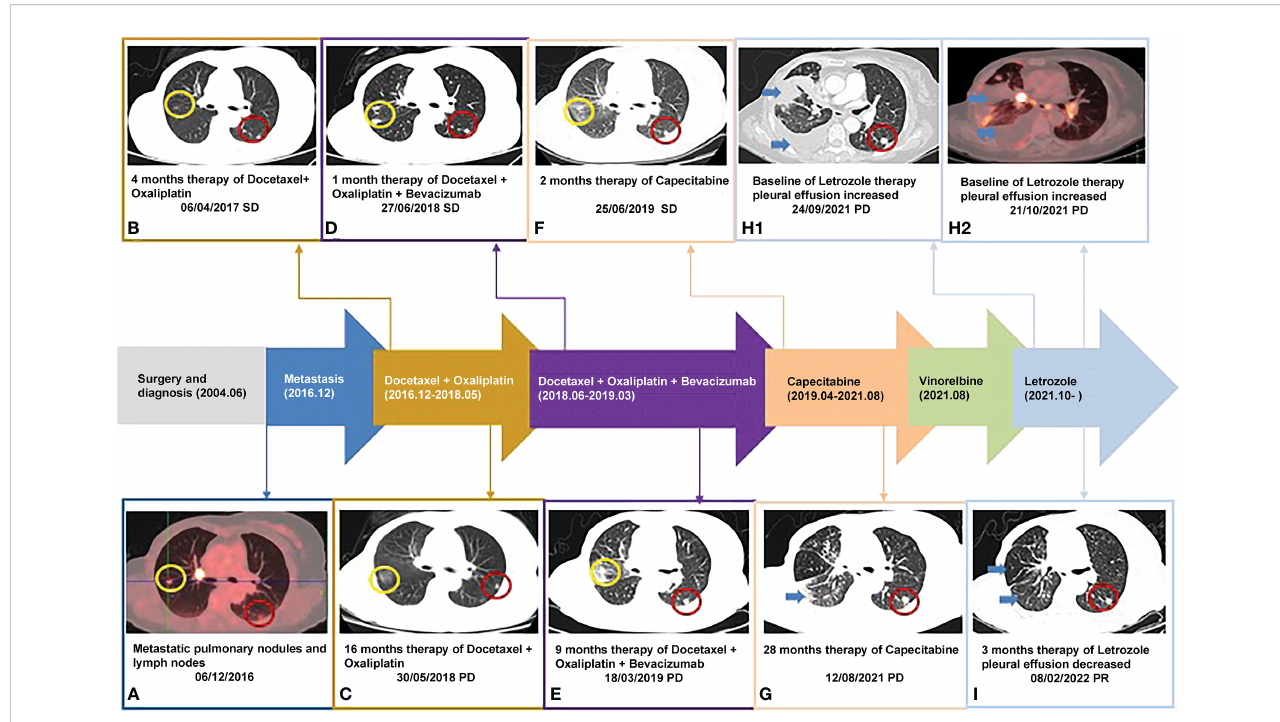
FIGURE 1 Timeline of the patient: (B-G, H1, I) were taken with Chest CT scanner and (A, H2) were taken with PET-CT scanner; yellow circle: right pulmonary nodule; red circle: right pulmonary nodule; blue arrow: pleural